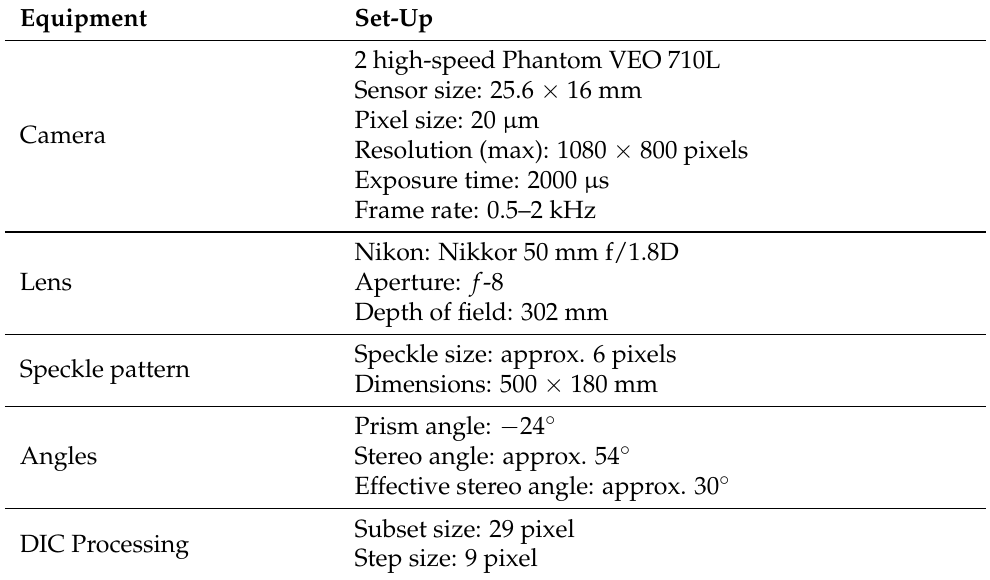
Figure 9. SSPA’s cavitation tunnel test section with the NACRA 17 foil with speckle pattern applied to it. Two high powered LED lights are used as white light imaging from the oval side window. Two Phantom VEO 710L high-speed cameras are recording the foil displacement through prisms from the circular side windows. Table 3. DIC performance table showing the equipment and the setting